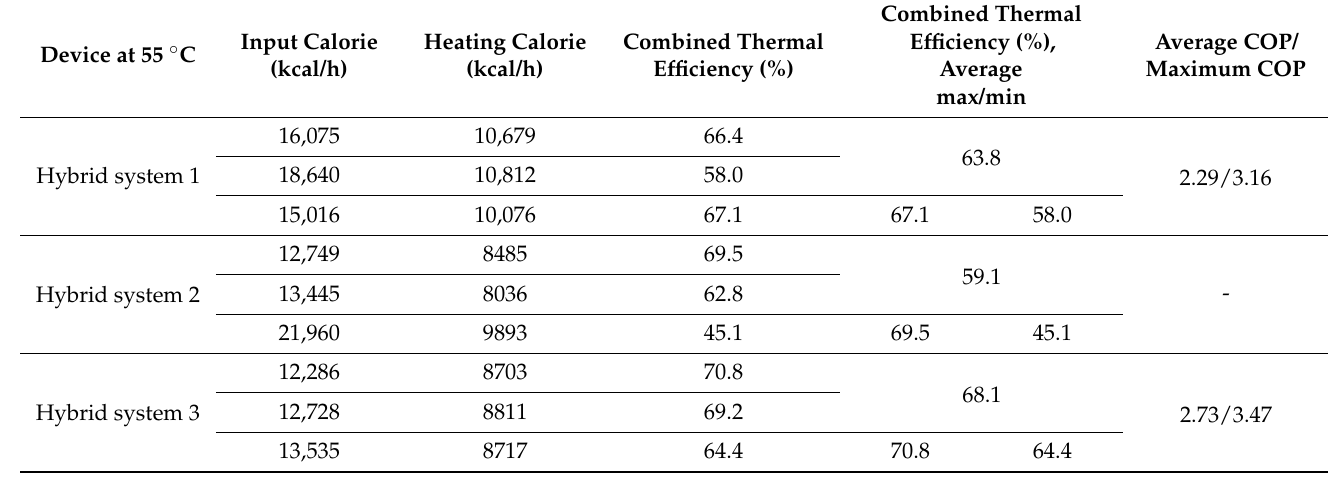
Table 5. Comparative analysis combined thermal efficiency.